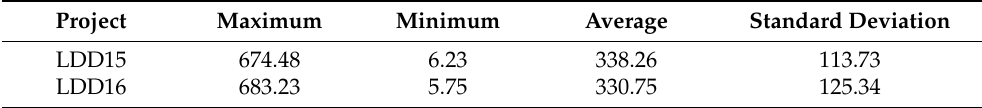
Table 2. Photosynthetically active radiation (PAR) at measurement points in 2015 and 2016.